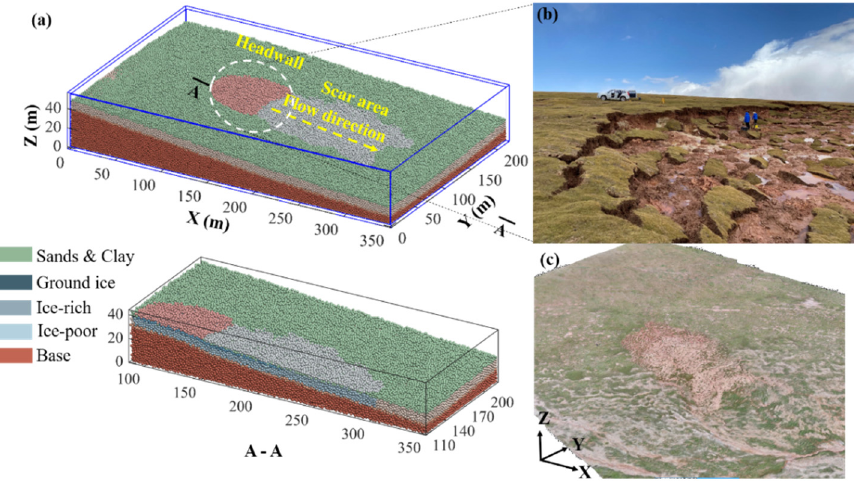
Figure 6. Basic discrete element model ( a ), details of the headwall ( b ), and the three-dimensional point cloud model ( c ) of the K1129W thaw slump.